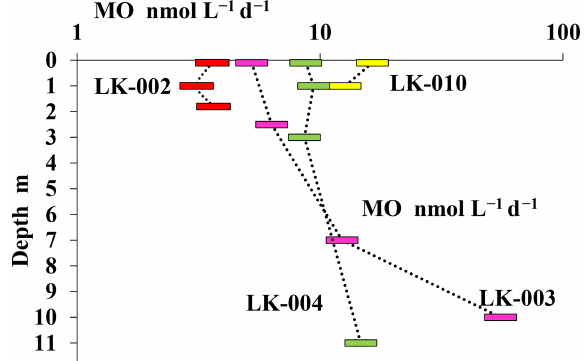
Figure 6. Rates of methane oxidation (nmol CH 4 L − 1 d − 1 ) in the water column of four Yamal tundra lakes: LK-002 (red), LK-010 (yellow), LK-003 (purple), and LK-004